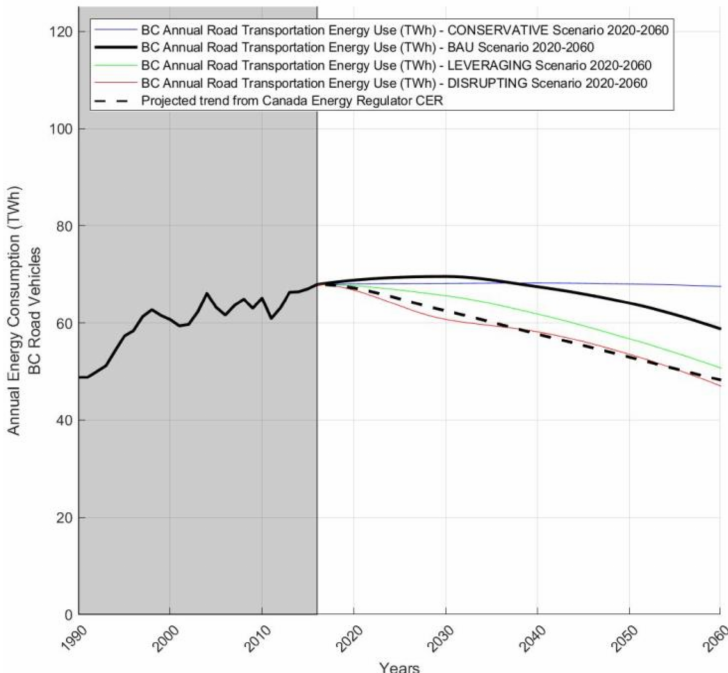
Figure 9. B.C. road transportation annual energy use in (TWh), impacts of vehicle electrification and travel demand increase due to vehicle automation.